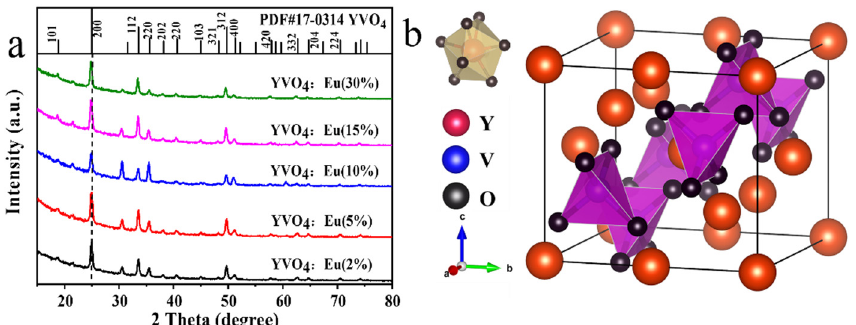
Table 1. The results of structure refinement and the crystalline sizes for YVO 4 :Eu 3+ .